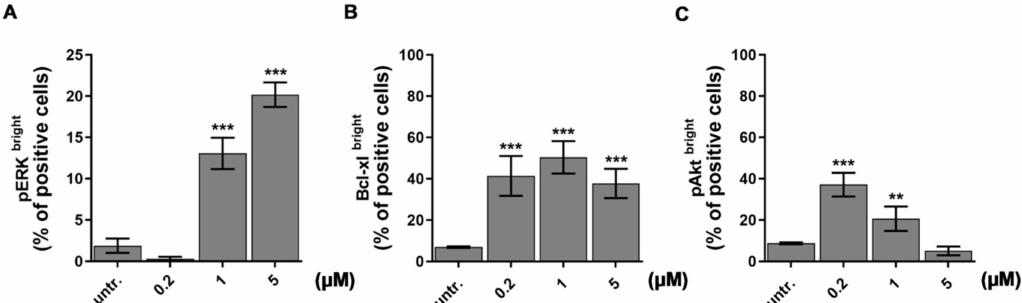
Figure 1. Drug candidate DU325 drives survival pathways as an early response to treatment in HL-60 cells. Using flow cytometry, we obtained ERK phosphorylation (pERK1 / 2, Thr202 / Tyr204) ( A ) as an early response to DU325 stimulation followed by the increase of the percentage of the Bcl-xl ( B ) and pAkt (Ser473) bright cells ( C ). Cells were treated as described in the Materials and Methods Section 4.12.4 for 2 h to assess ERK1 / 2 phosphorylation, and for 24 h to assess the upregulation of the anti-apoptotic Bcl-xl bright and pAkt bright cells. Data are shown as arithmetic mean values ± standard deviation from triplicate experiments. Statistical significance was calculated in relation to untreated cells and set to ** p < 0.01, *** p <